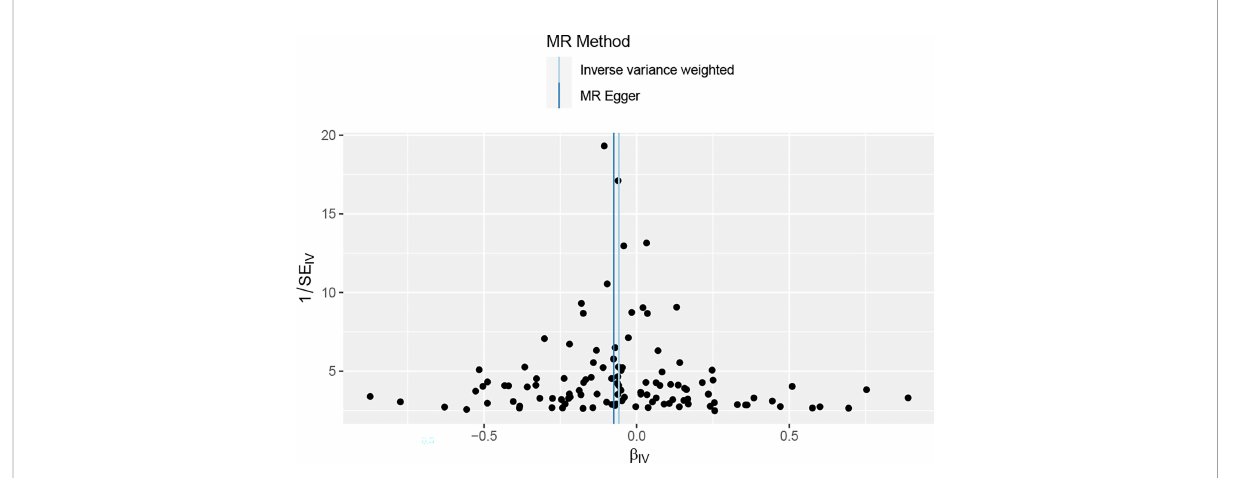
FIGURE 4 The funnel plot of the association between periodontal and TL, reverse MR analysis;It is used to determine whether the associations observed are noticeably